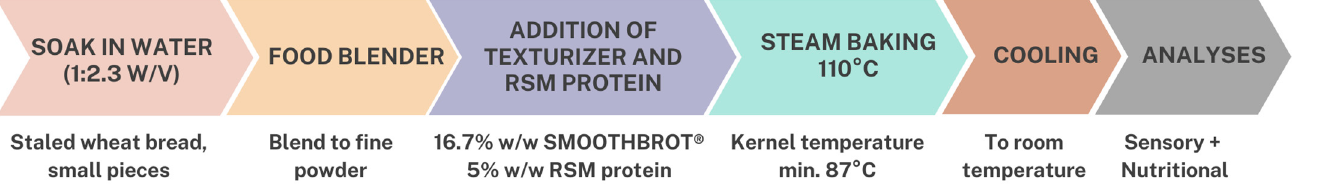
Figure 3. Flow-chart of TM bread preparation.